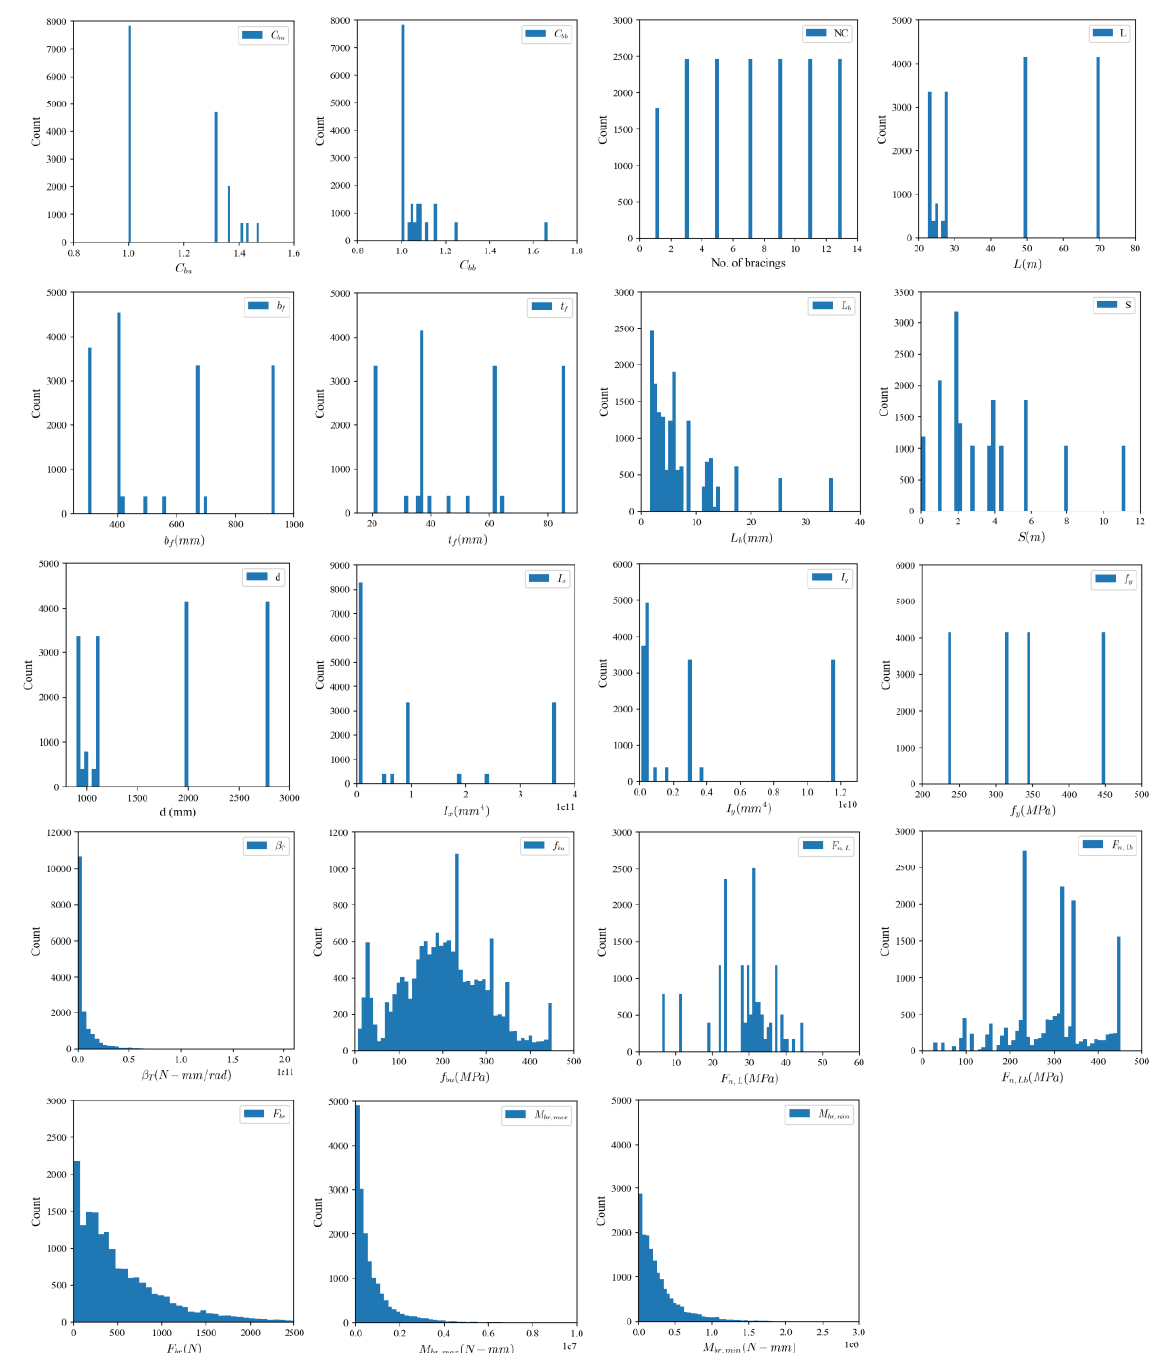
Figure 6. Histograms of input and output variables used in training.